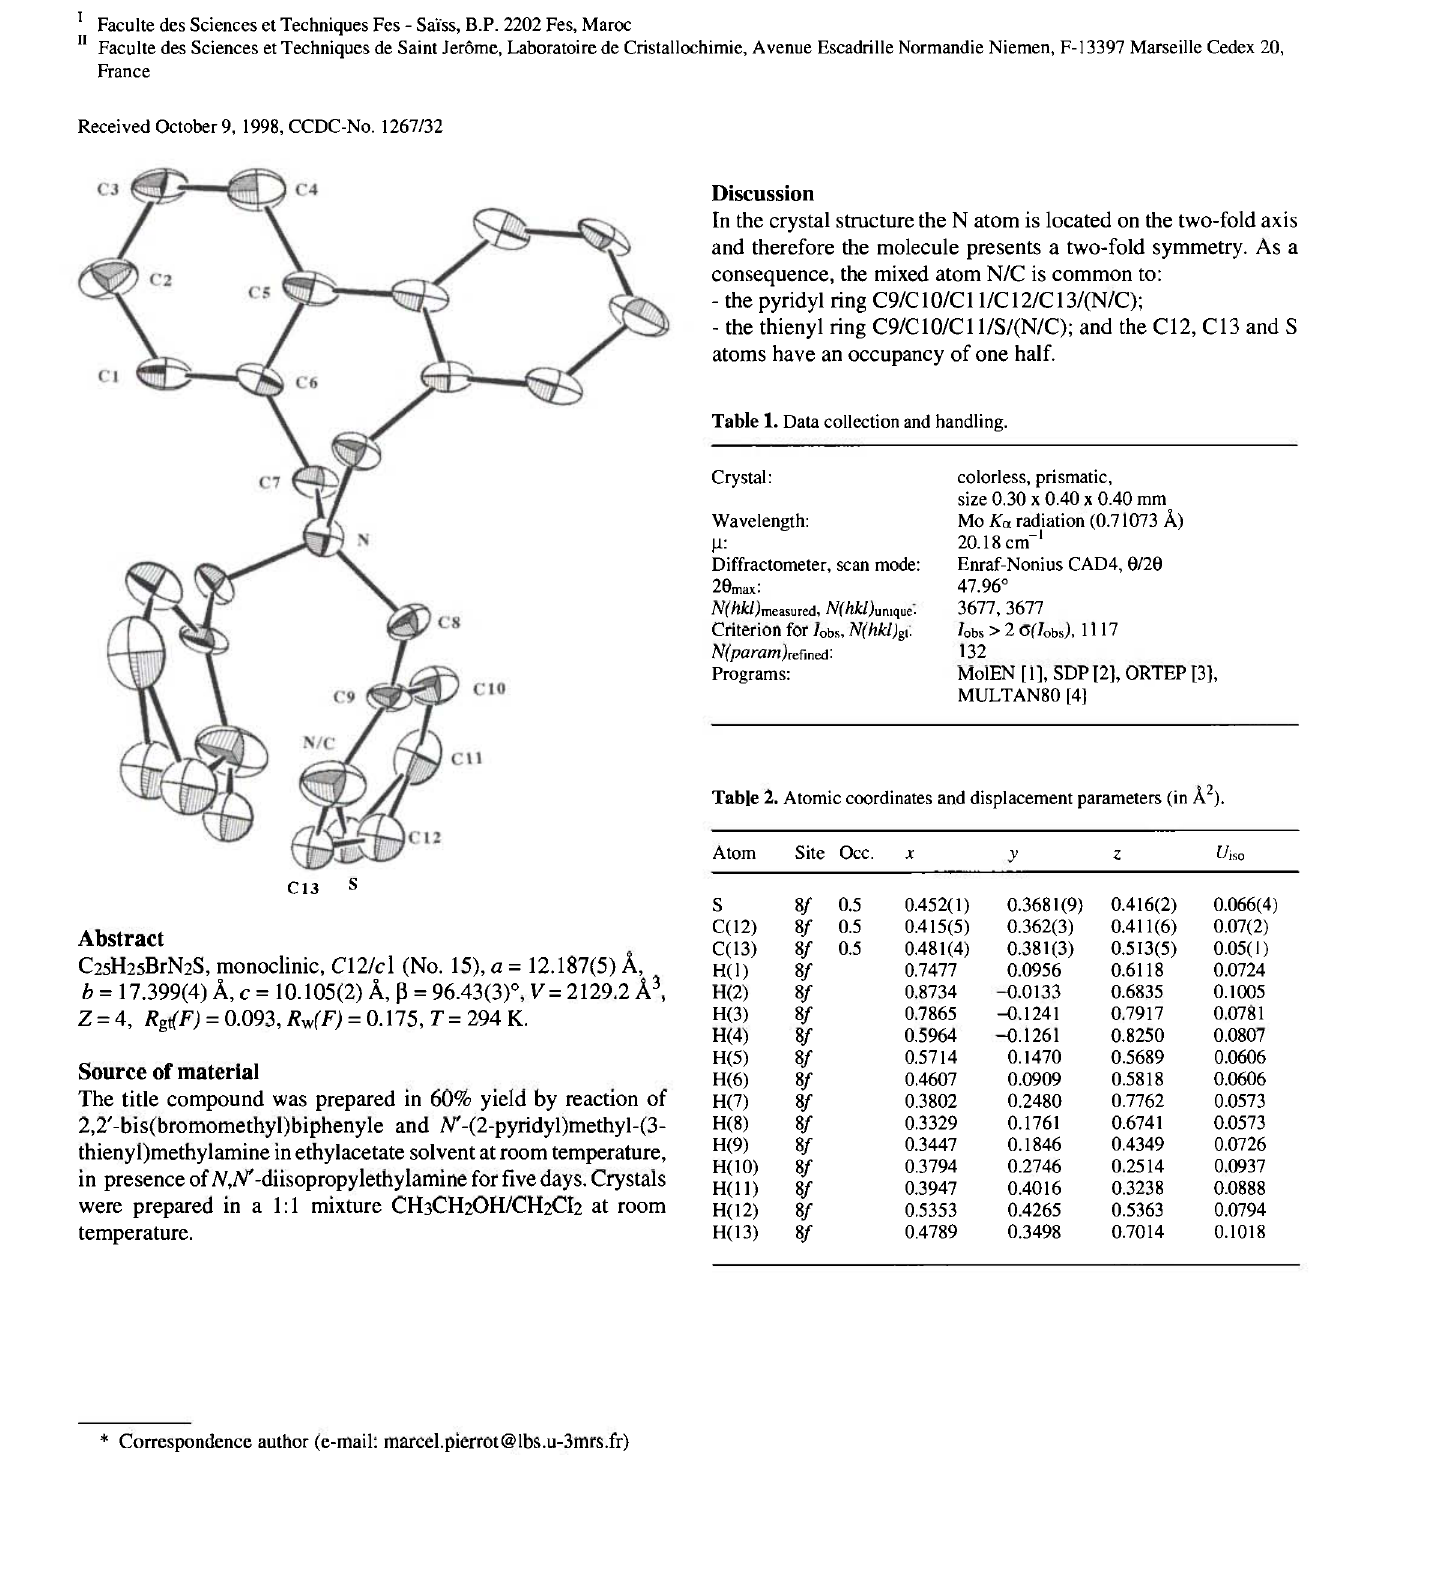
Table 1. Data collection and handling.